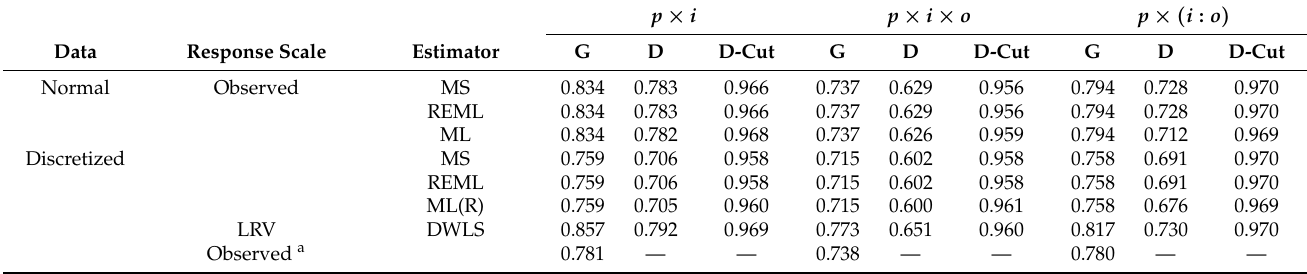
Table 2. Estimated generalizability and dependability coefficients for normal and discretized data under different